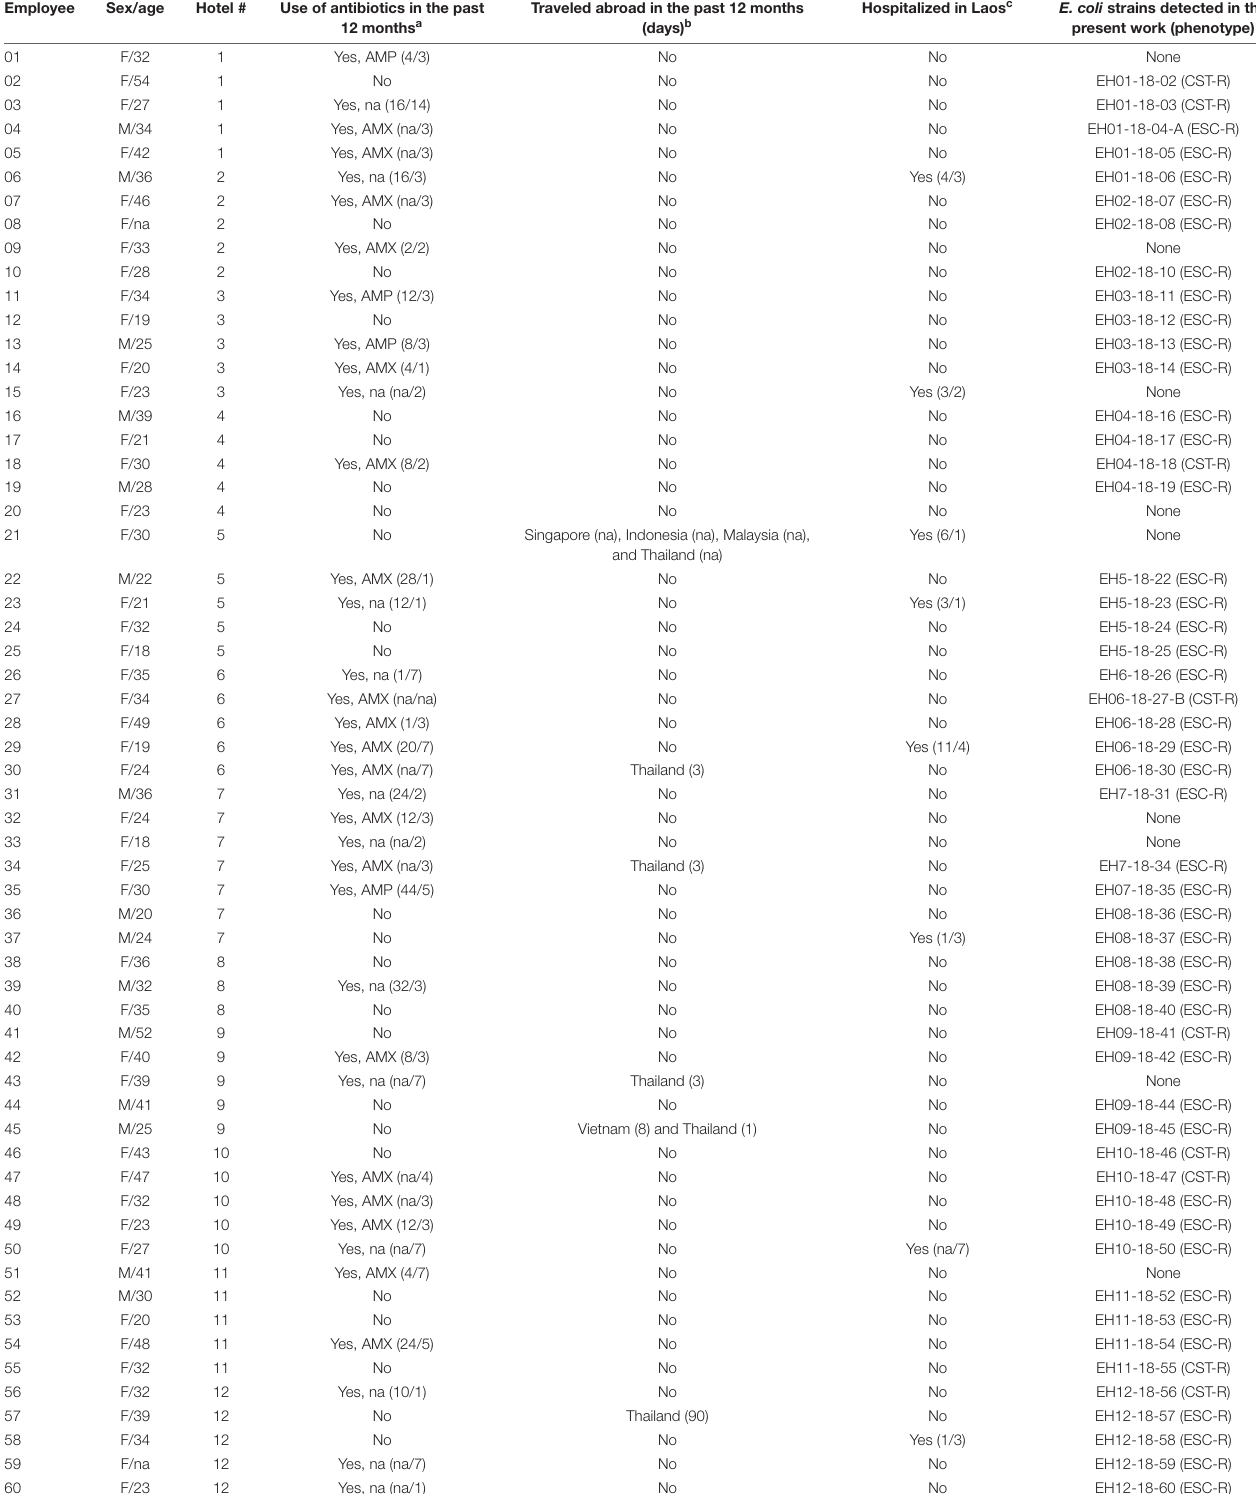
TABLE 1 | Demographic and clinical characteristics of the 60 local (Laos) people in the community enrolled in the present study. Employee Sex/age Hotel # Use of antibiotics in the past Traveled abroad in the past 12 months Hospitalized in Laos c E. coli strains detected in the 12 months a (days) b present work